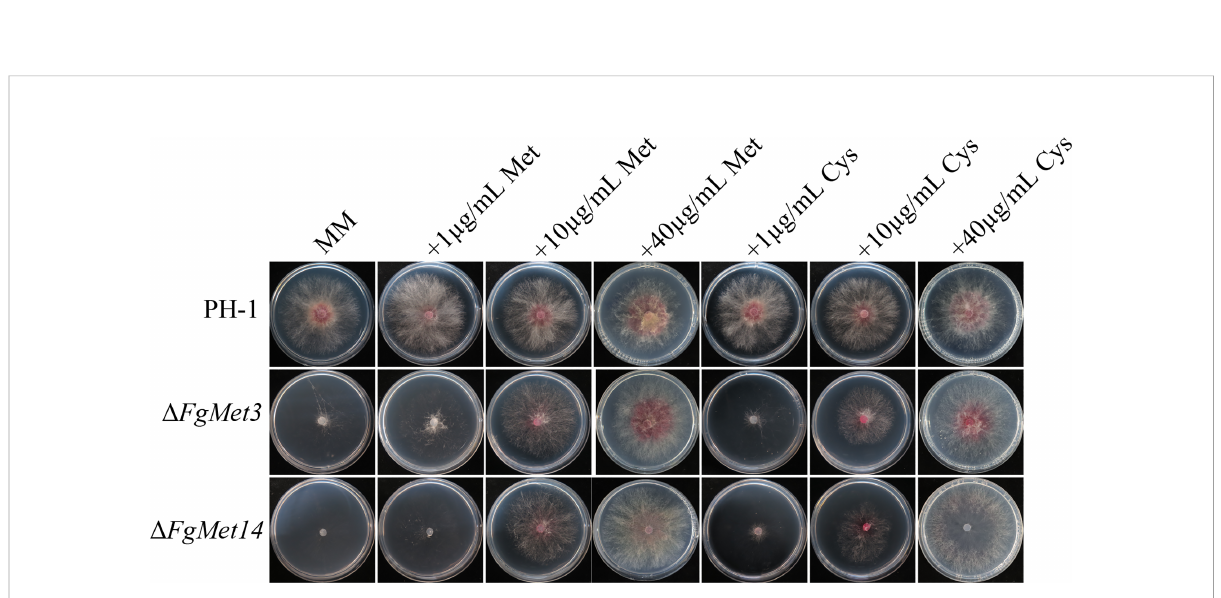
Values are means and standard errors of three replicates. The same letter indicate no signi fi cant difference according to the least signi fi cant difference (LSD) test at p = 0.05.